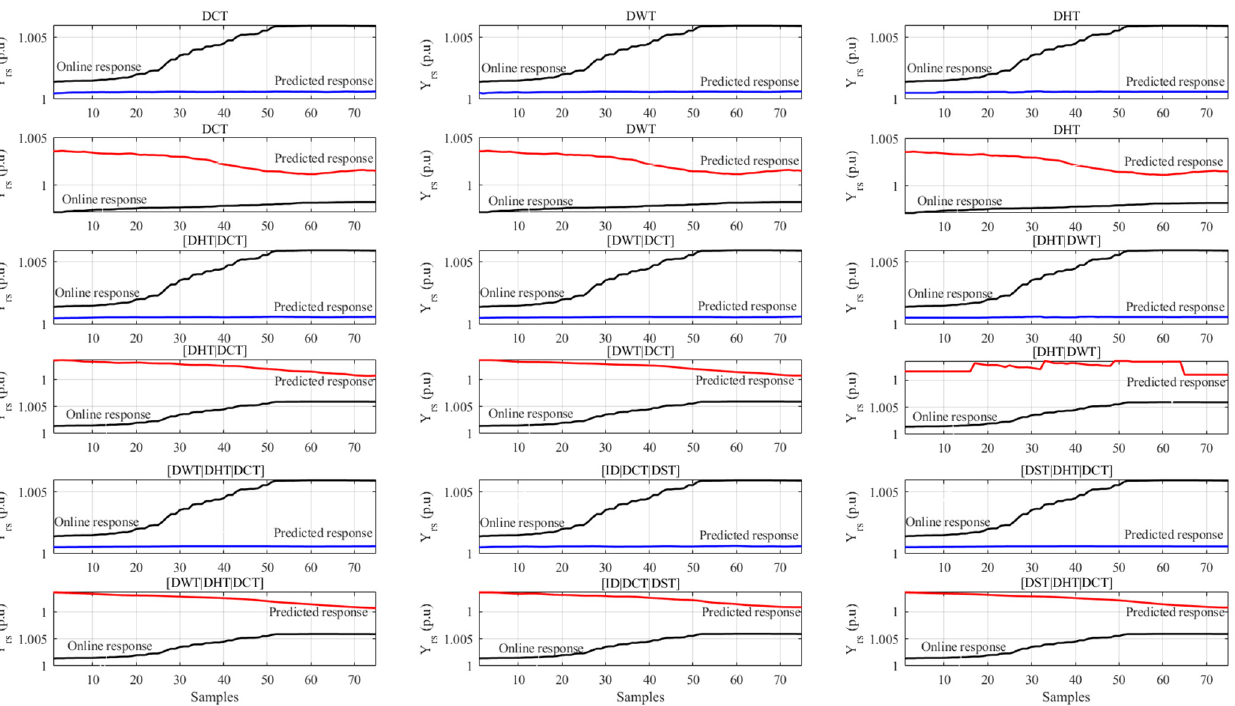
Figure 6. Online & OHD reconstruction of stable (blue) and unstable (red) of sample signal’s response in the test dataset.